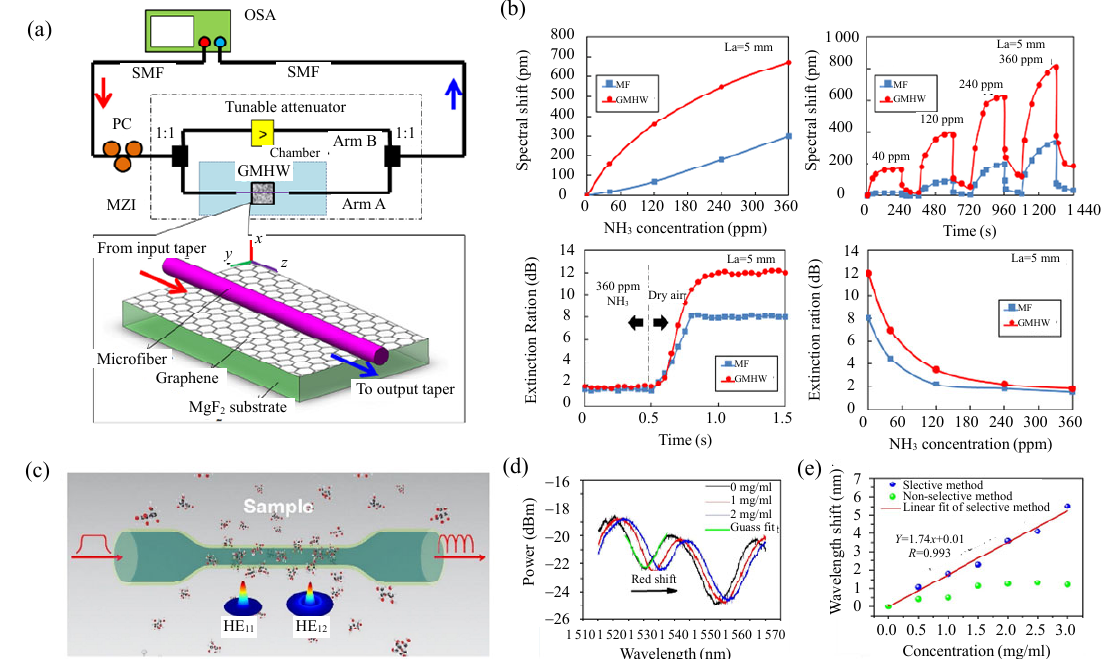
Fig. 10 Phase-based MFI sensors: (a) schematic diagram of a graphene/microfiber hybrid waveguide (GMHW) and setup of the GMHW-MZI for NH 3 sensing. Reproduced with permission [191]. Copyright 2014 Elsevier; (b) sensing performances of the GMHW (red) and the microfiber on MgF 2 without graphene attached (blue). Reproduced with permission [191]. Copyright 2014 Elsevier; (c) schematic diagram of a functionalized microfiber modal interferometer for selective and highly sensitive glucose detection. Reproduced with permission [195]. Copyright 2018 Elsevier; (d) spectra of the functionalized MFI in glucose solutions with different concentrations. Reproduced with permission [195]. Copyright 2018 Elsevier; (e) relationship between resonant wavelength shift and concentration for the functionalized MFI. Reproduced with permission [195]. Copyright 2018